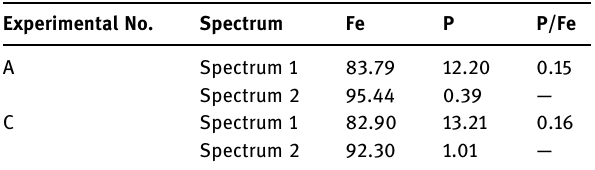
Table 4: EDS of each phase from samples in Figure 12 ( mass frac - tion, % ) Experimental